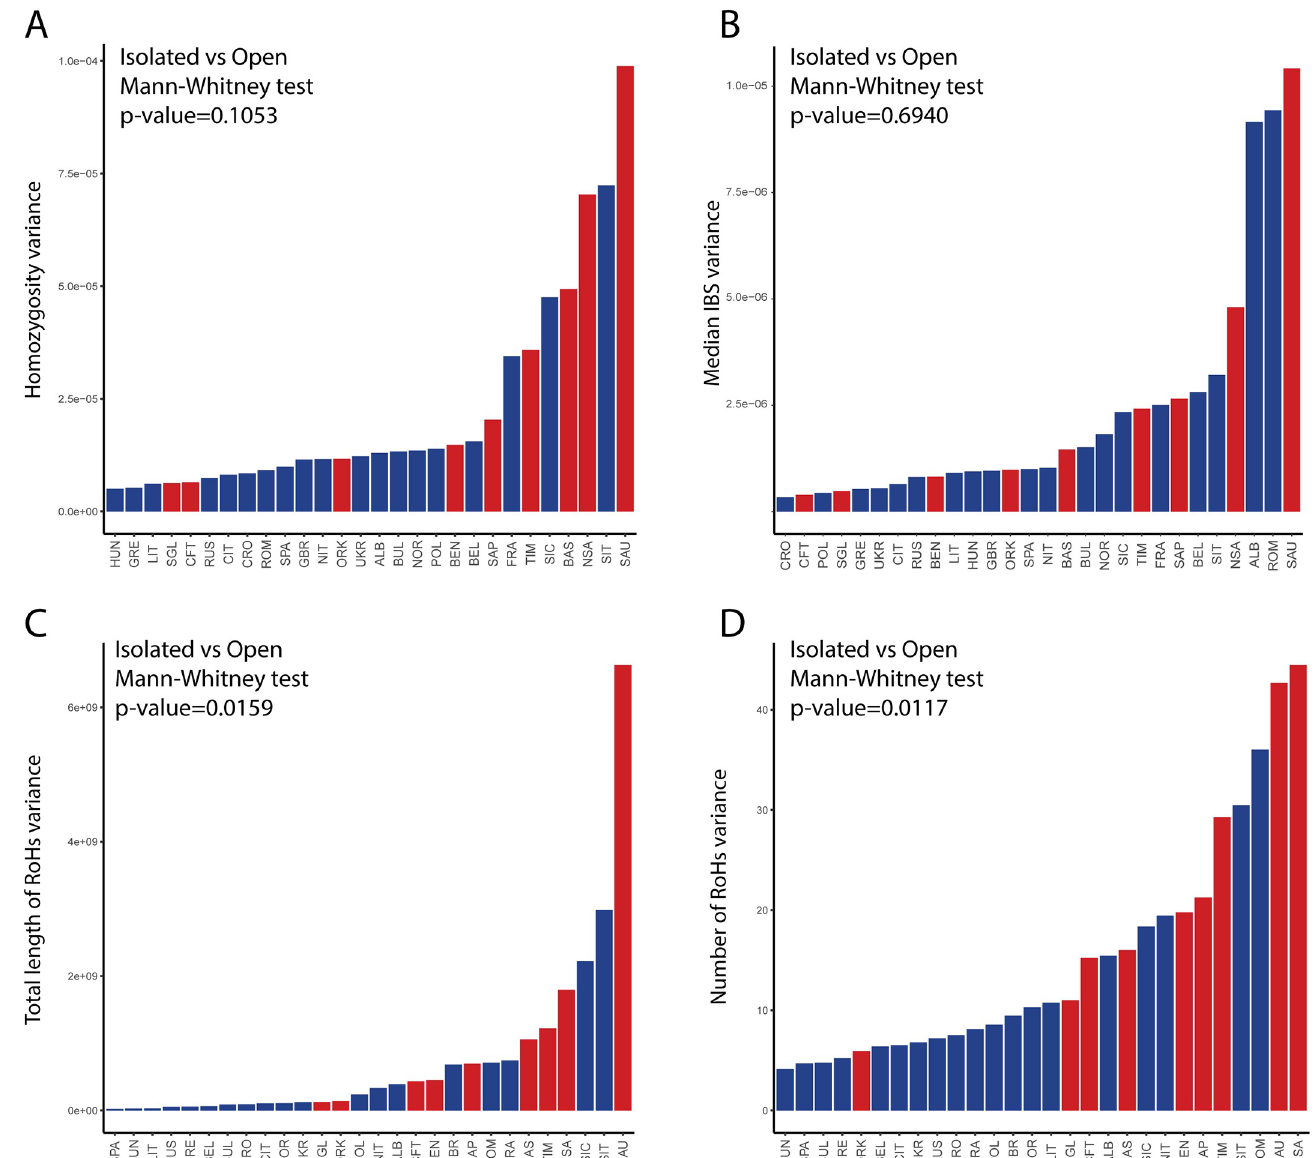
Fig 2. Distribution of inter-individual heterogeneity values across populations and Mann-Whitney U test. Comparison between isolated (red) and open (blue) populations for homozygosity (A), median values of intra-population IBS (B), number of RoHs (C) and total length of RoHs (D).